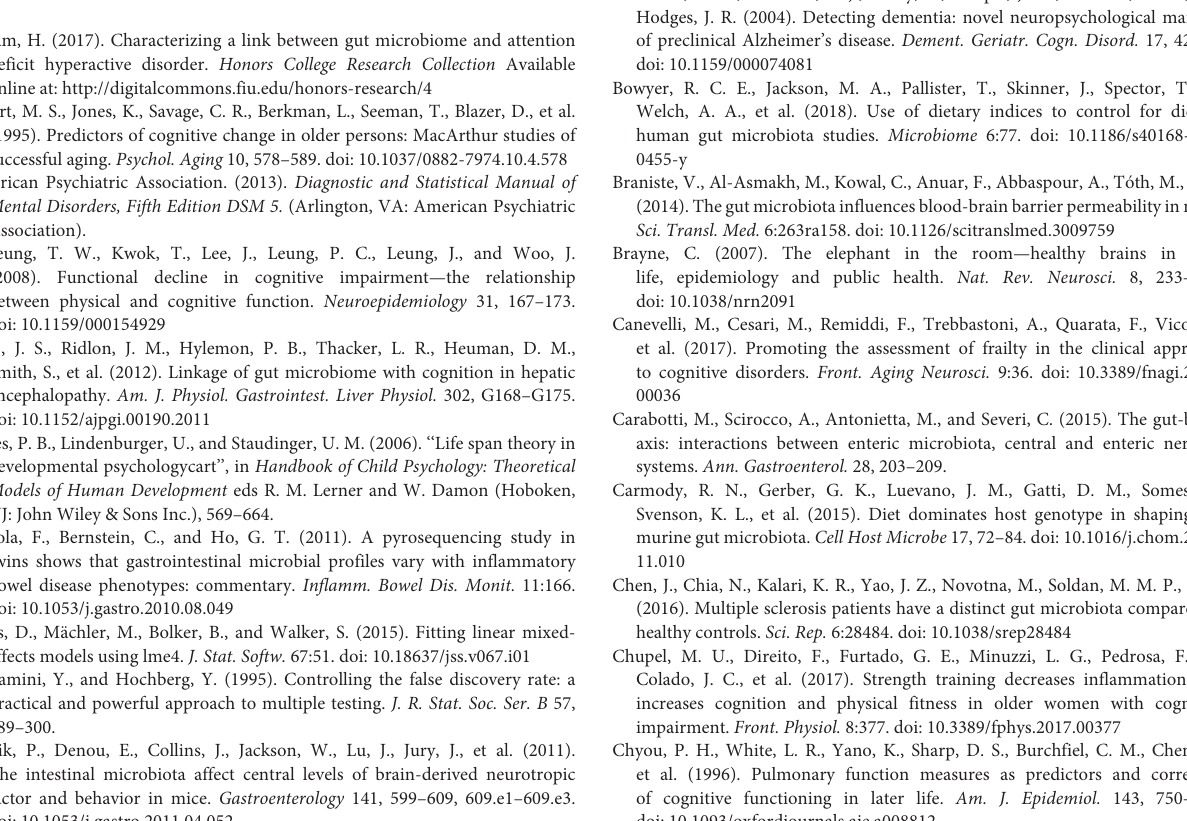
TABLE S1 | The results of association analyses vs. cognitive measures.